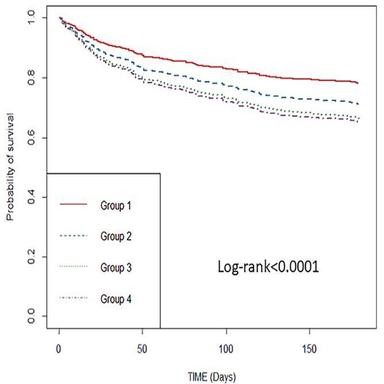
Kaplan-Meier curves according to patient group (left) and box-plot of the adjusted Cox regression analysis. DBP: diastolic blood pressure; LVEF: left ventricular ejection fraction; SBP: systolic blood pressure.